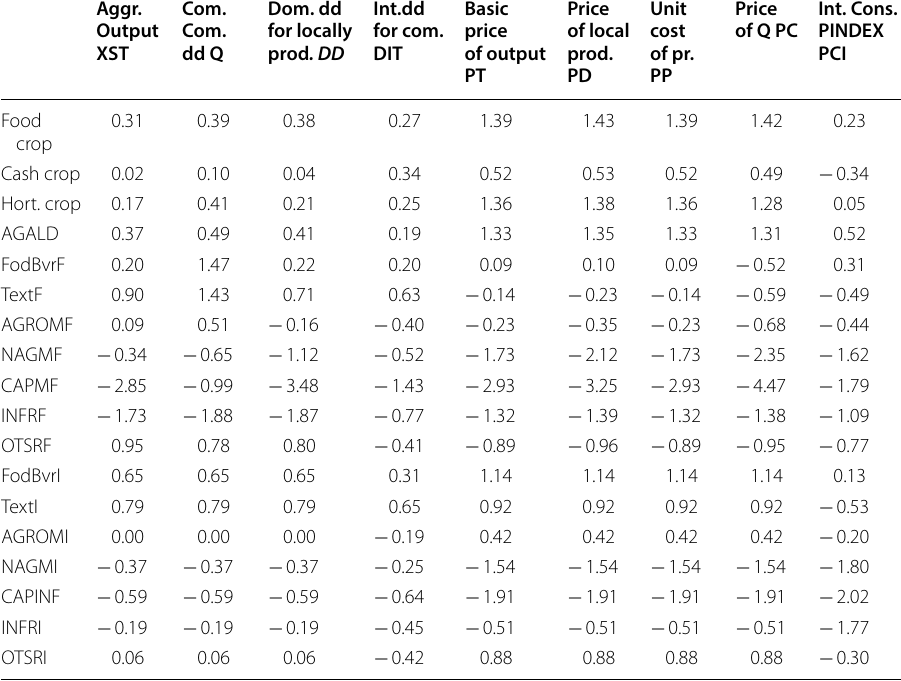
Table 8 (Scenario A2-S1) Change (%) in quantity and price due to 50% tariff reduction (no = 0.2 ) segmentation labour market, σ LD j